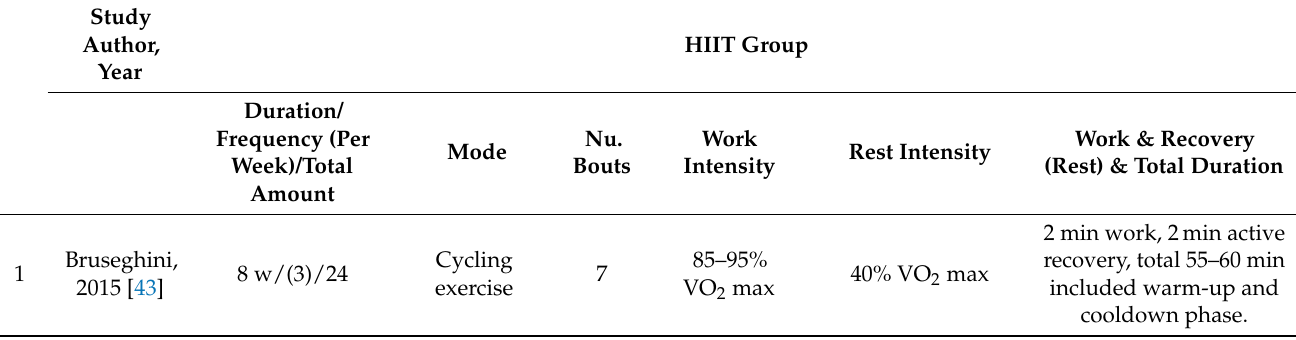
Table 2. Characteristics of the HIIT